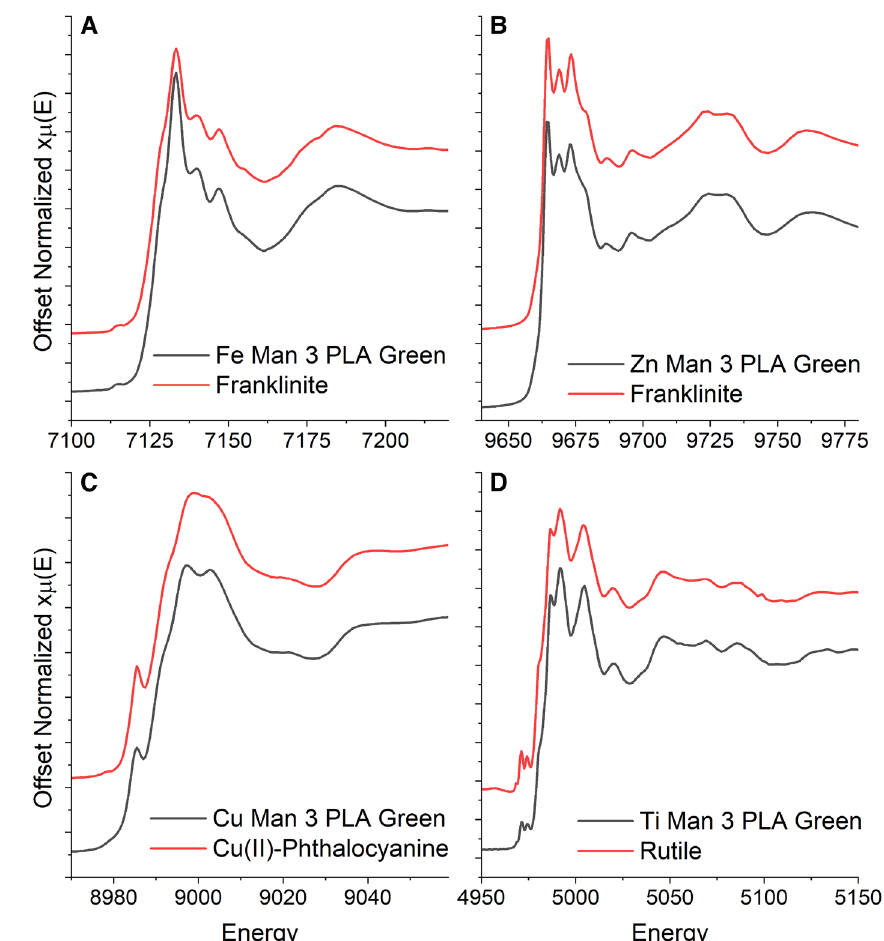
Fig. 3 X-ray absorption spectra of a iron, b zinc, c copper, and d titanium from the PLA Green filament from Man. 3. Each filament spectrum is the lower black line. The upper red line corresponds to the predomi- nant species (> 90%) identified from the spectra. Included as the upper red line in a is frank- linite/zinc ferrite, in b franklin- ite/zinc ferrite, in c copper(II) phthalocyanine [blue], and in d rutile/titanium(IV)